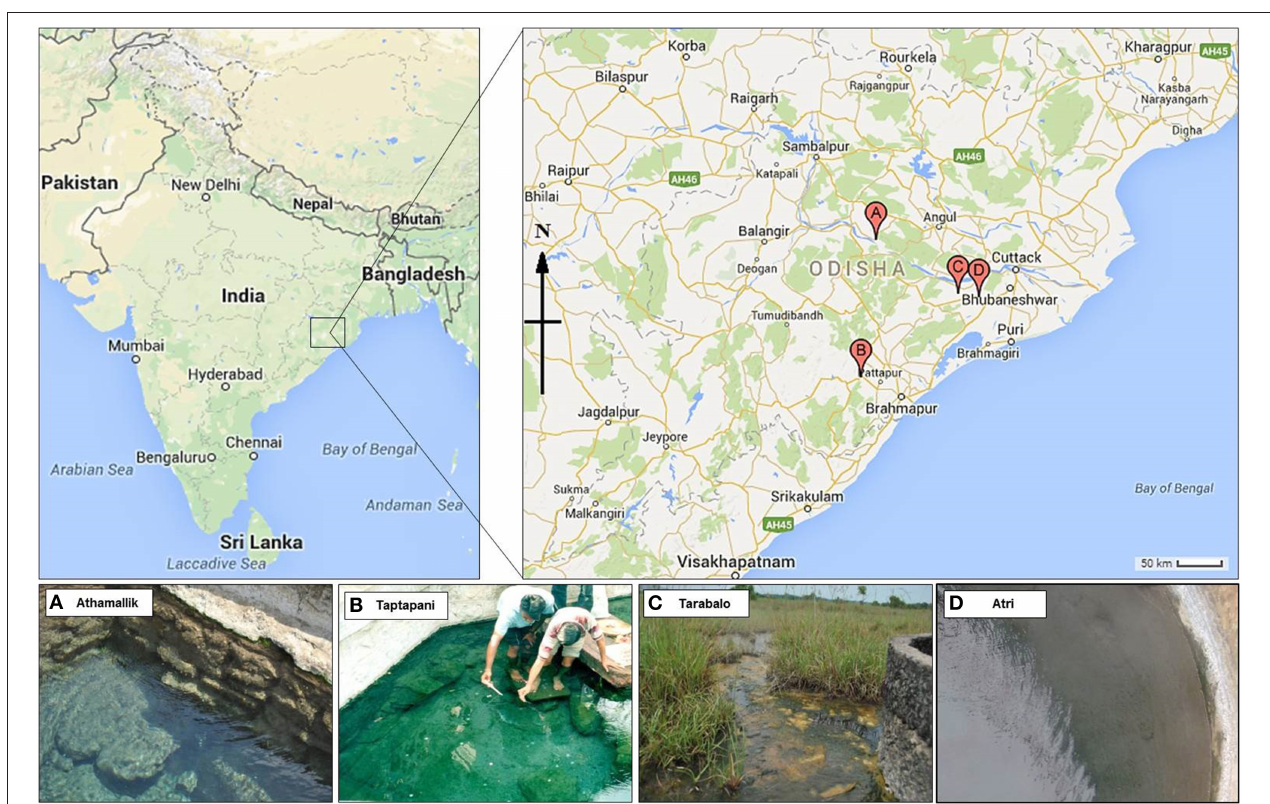
FIGURE 1 | Geographical location of the four hot springs. Point A, B, C, and D on the map represent the hot spring Athamallik, Taptapani, Tarabalo, and Atri,